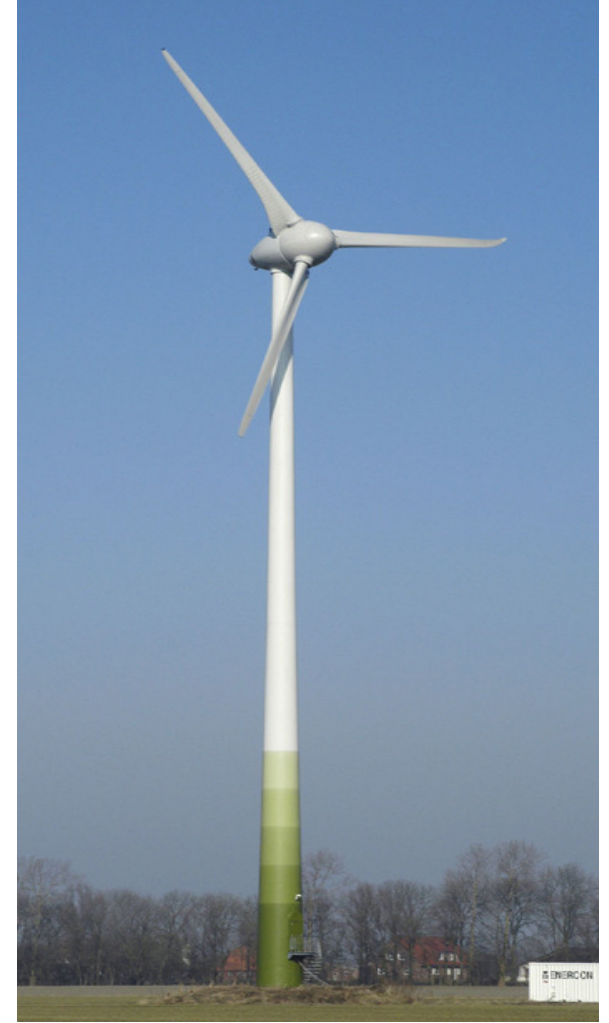
Fig. 2. Investigated wind turbine in